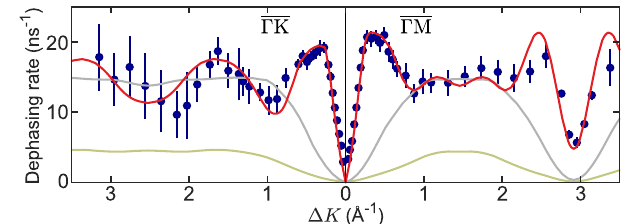
Fig. 5 Evidence for repulsive interactions in the diffusion process. Experimental dephasing rates for coherent scattering (blue dots, with the error bars correspnding to the 1 σ con fi dence bounds) compared with kinetic Monte Carlo simulations (solid curves). The simulations add a force (Eq. (4)) to the hopping model derived earlier. The experimental data are described well by repulsive dipole forces (red curve) but models using attractive forces (green curve) or no forces (grey curve) cannot reproduce the data. Note that the model without forces (grey curve) is, as expected, similar to the analytic curve for incoherent scattering shown in